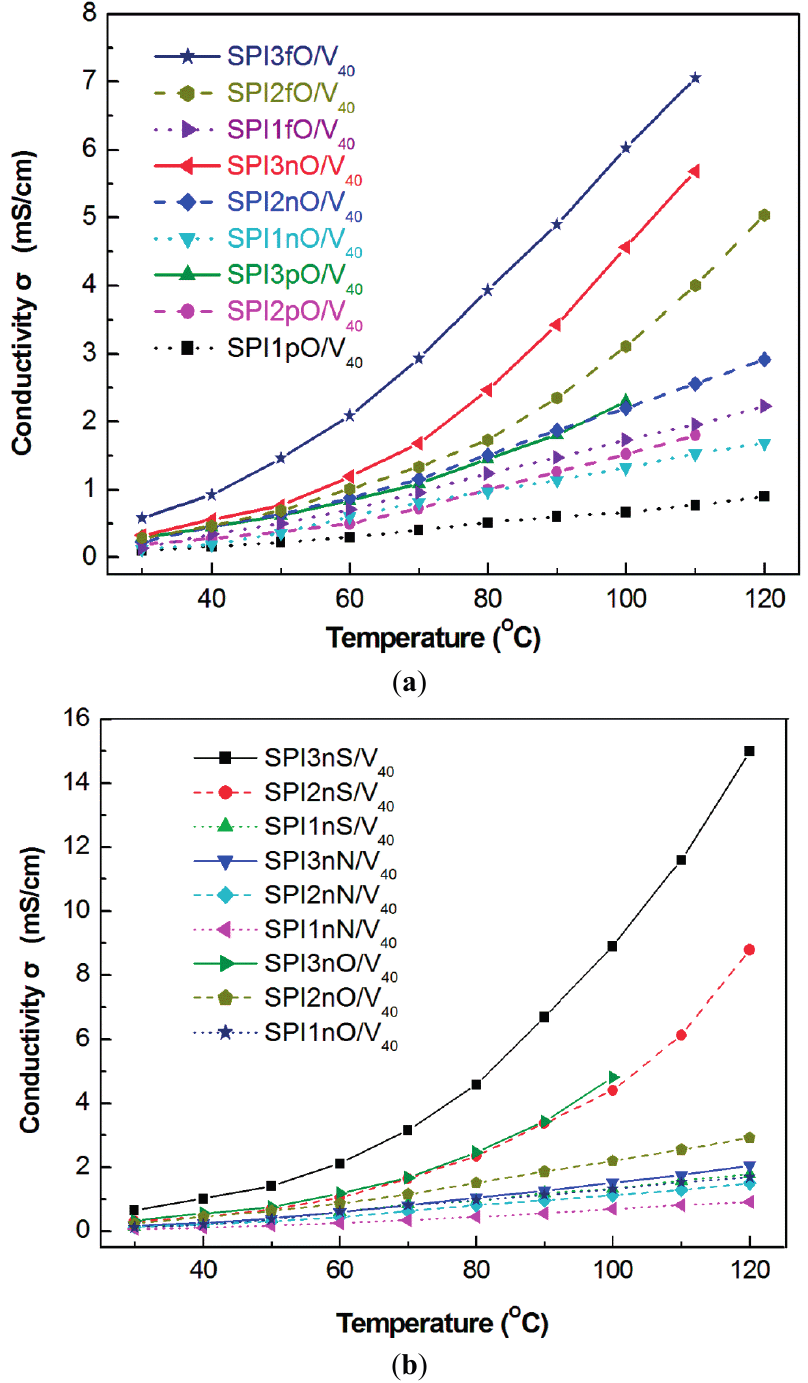
Figure 6. Temperature dependence of conductivity of SPI/PIL composite membranes prepared from ( a ) ODPA dianhydride and various diamines; and ( b ) BAPN diamine and various